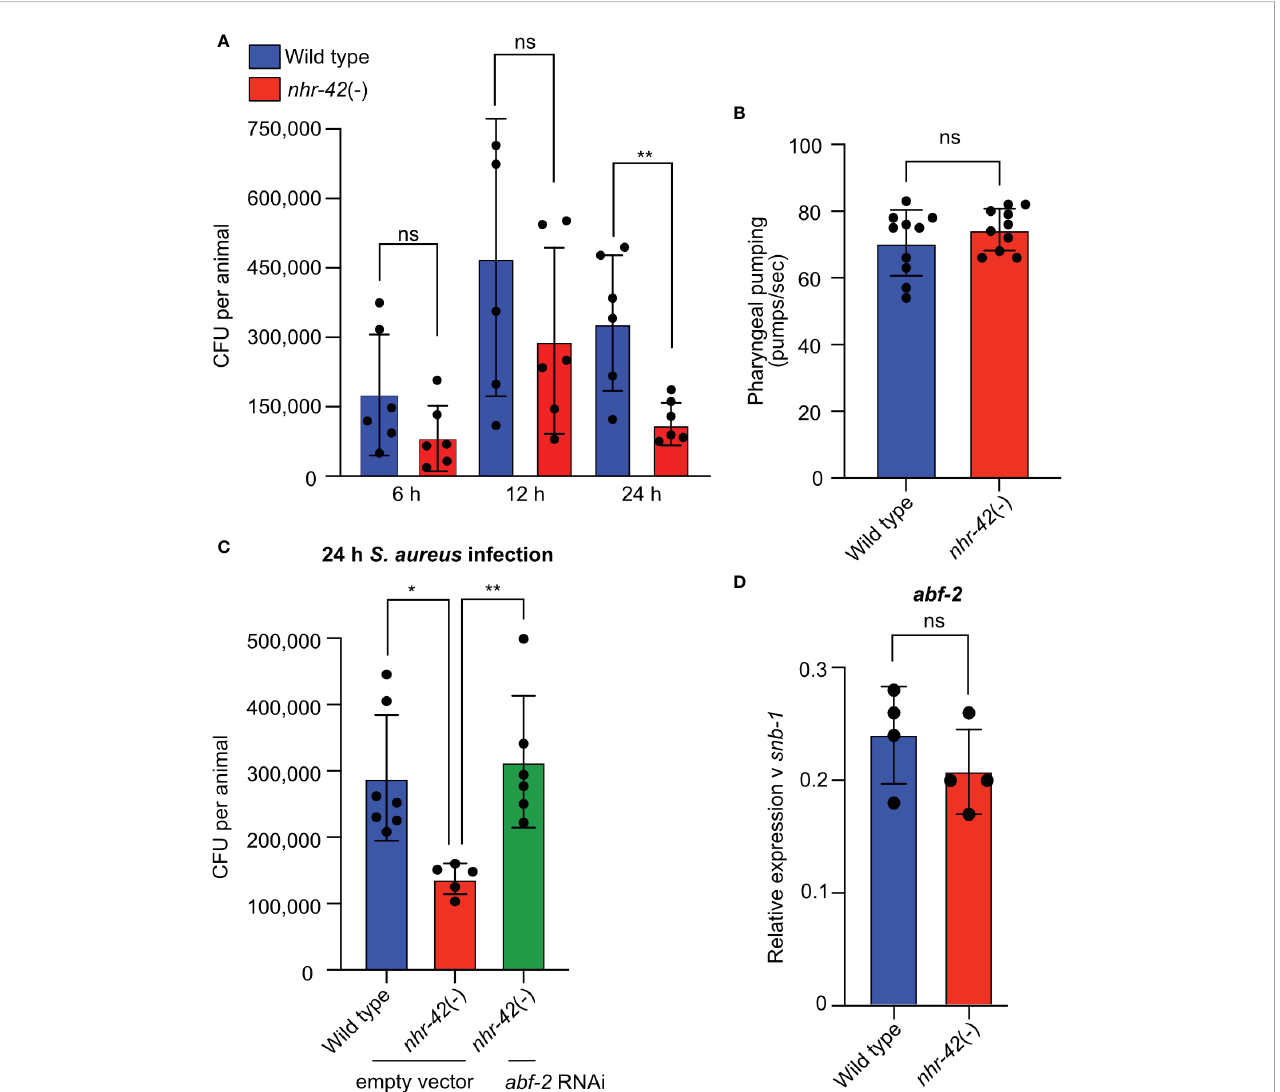
FIGURE 7 abf-2 mediates infection resistance in nhr-42 mutants (A) S. aureus SH1000 colony forming units (CFU) from wild type and nhr-42 (tm1375) animals after 6, 12, and 24 h of infection. Each dot represents a single animal (N = 6 per time point). Means ± SD. (B) Pumping rates of noninfected wild type and nhr- 42 (tm1375) animals. Each dot represents a single animal (N = 10). Means ± SD. (C) S. aureus SH1000 CFU from wild type and nhr-42 (tm1375) animals fed E. coli HT115 expressing RNAi empty vector or abf-2 dsRNA prior to infection for 24 h. Each dot represents a single animal (N = 5-7). Means ± SD. (D) RT-qPCR of abf-2 transcript in infected wild type and nhr-42 (tm1375) animals. Each dot represents a single biological replicate of ~1,000 animals. Means ± SD. * P ≤ 0.05, ** P ≤ 0.01. ns, not signi fi cant. 2-sided 2-sample unpaired t